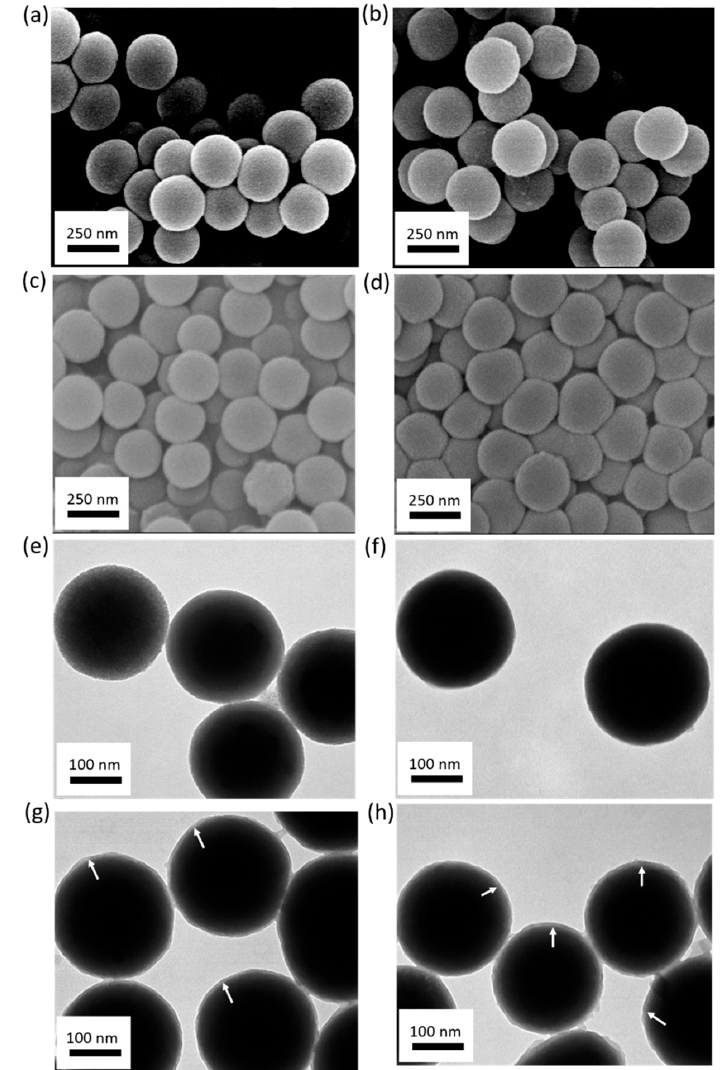
Figure 2. SEM images of ( a ) silica nanoparticles, ( b ) Si@BA, ( c ) HRP–MIP, and ( d ) NIP. TEM images of ( e ) silica nanoparticles, ( f ) Si@BA, ( g ) HRP–MIP, and ( h )